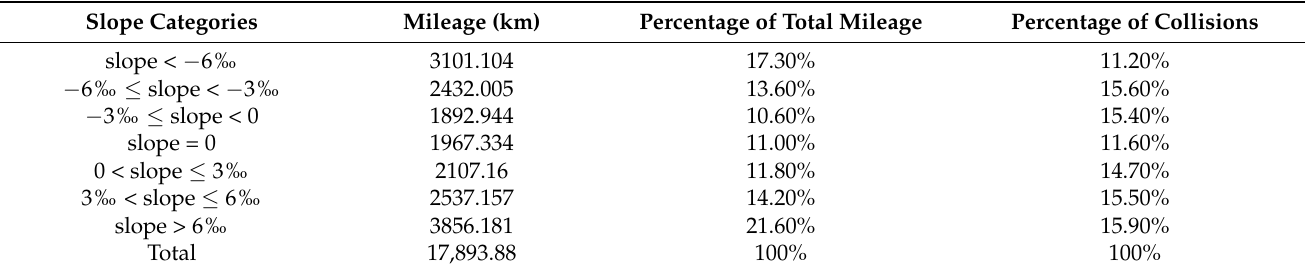
Table 5. Distribution of different slope ranges in the total mileage and